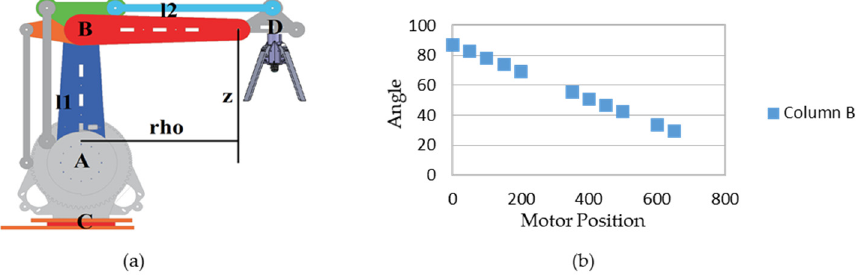
Figure 11. ( a ) Segments, angles, and coordinates of the arm. ( b ) Angle vs. motor position for the segment.